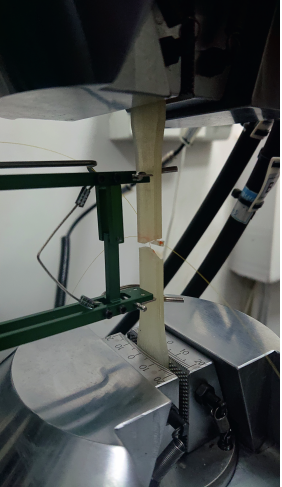
Figure 15. The sample mounted into the tensile machine jaws.